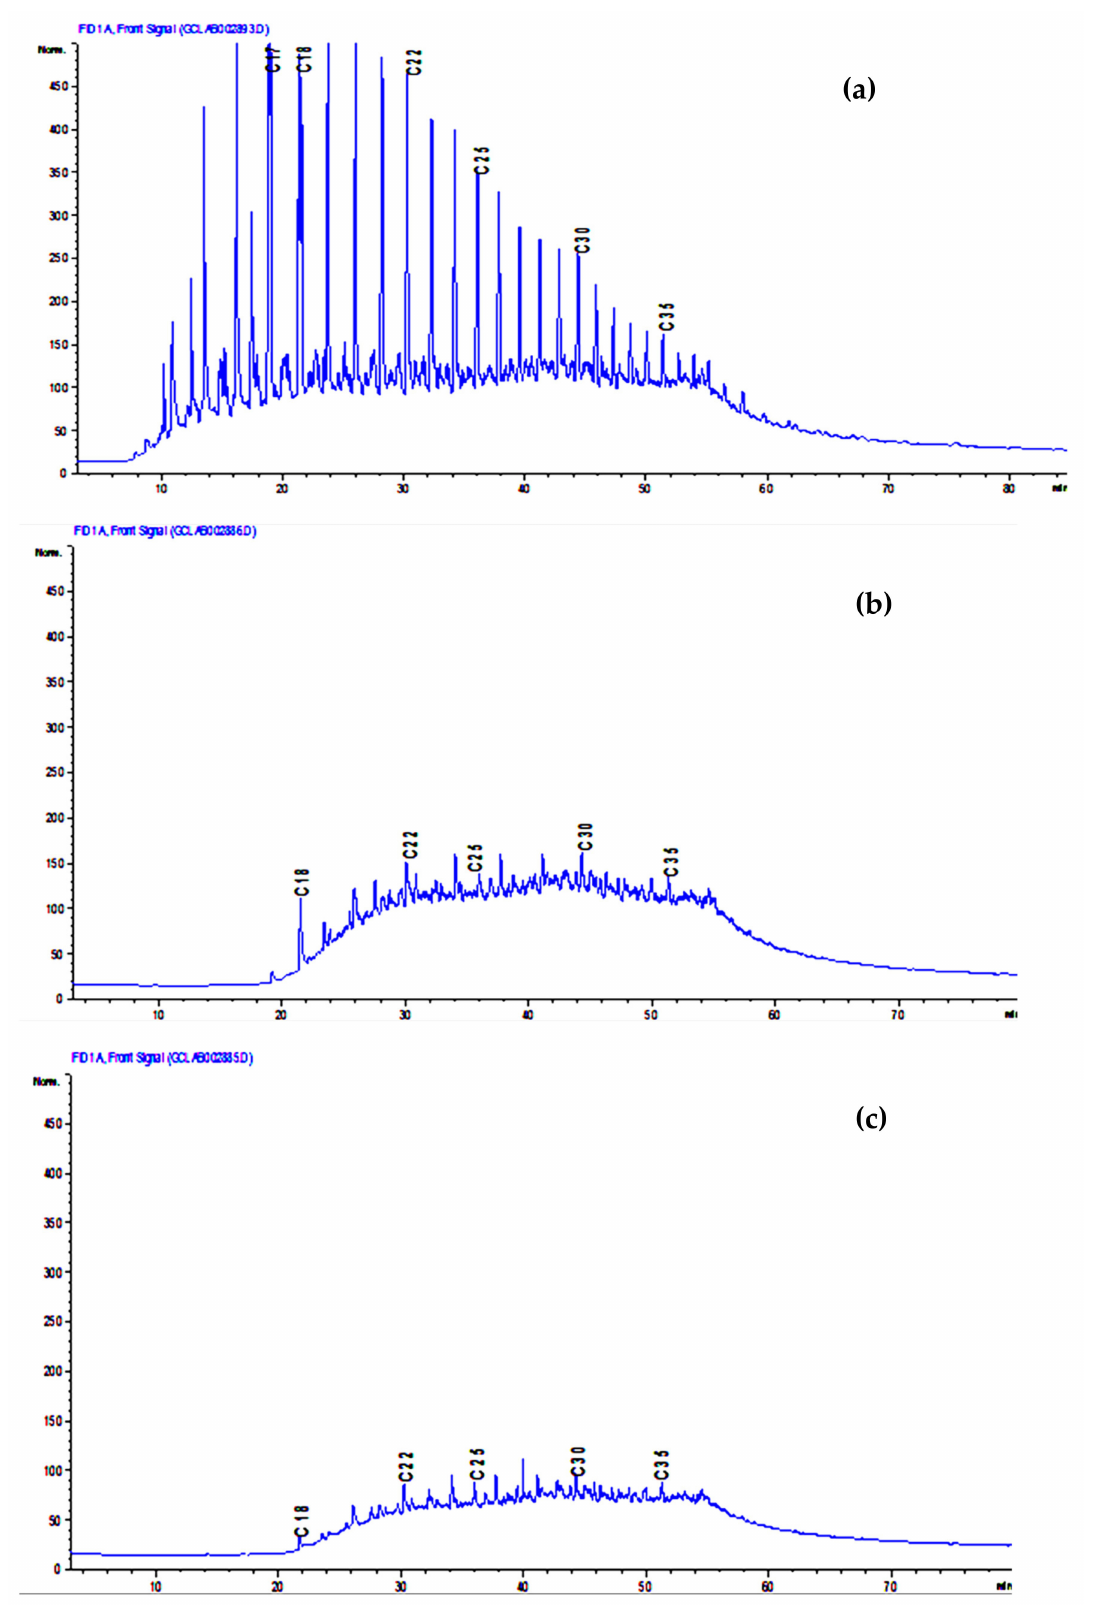
Figure 2. Gas chromatograms of saturated hydrocarbon fractions in 0.5 g crude oil before use ( a ), after a 7-daygrowth period in 0.5 g/L polluted unplanted water ( b ) and planted polluted water with the A-A combination ( c